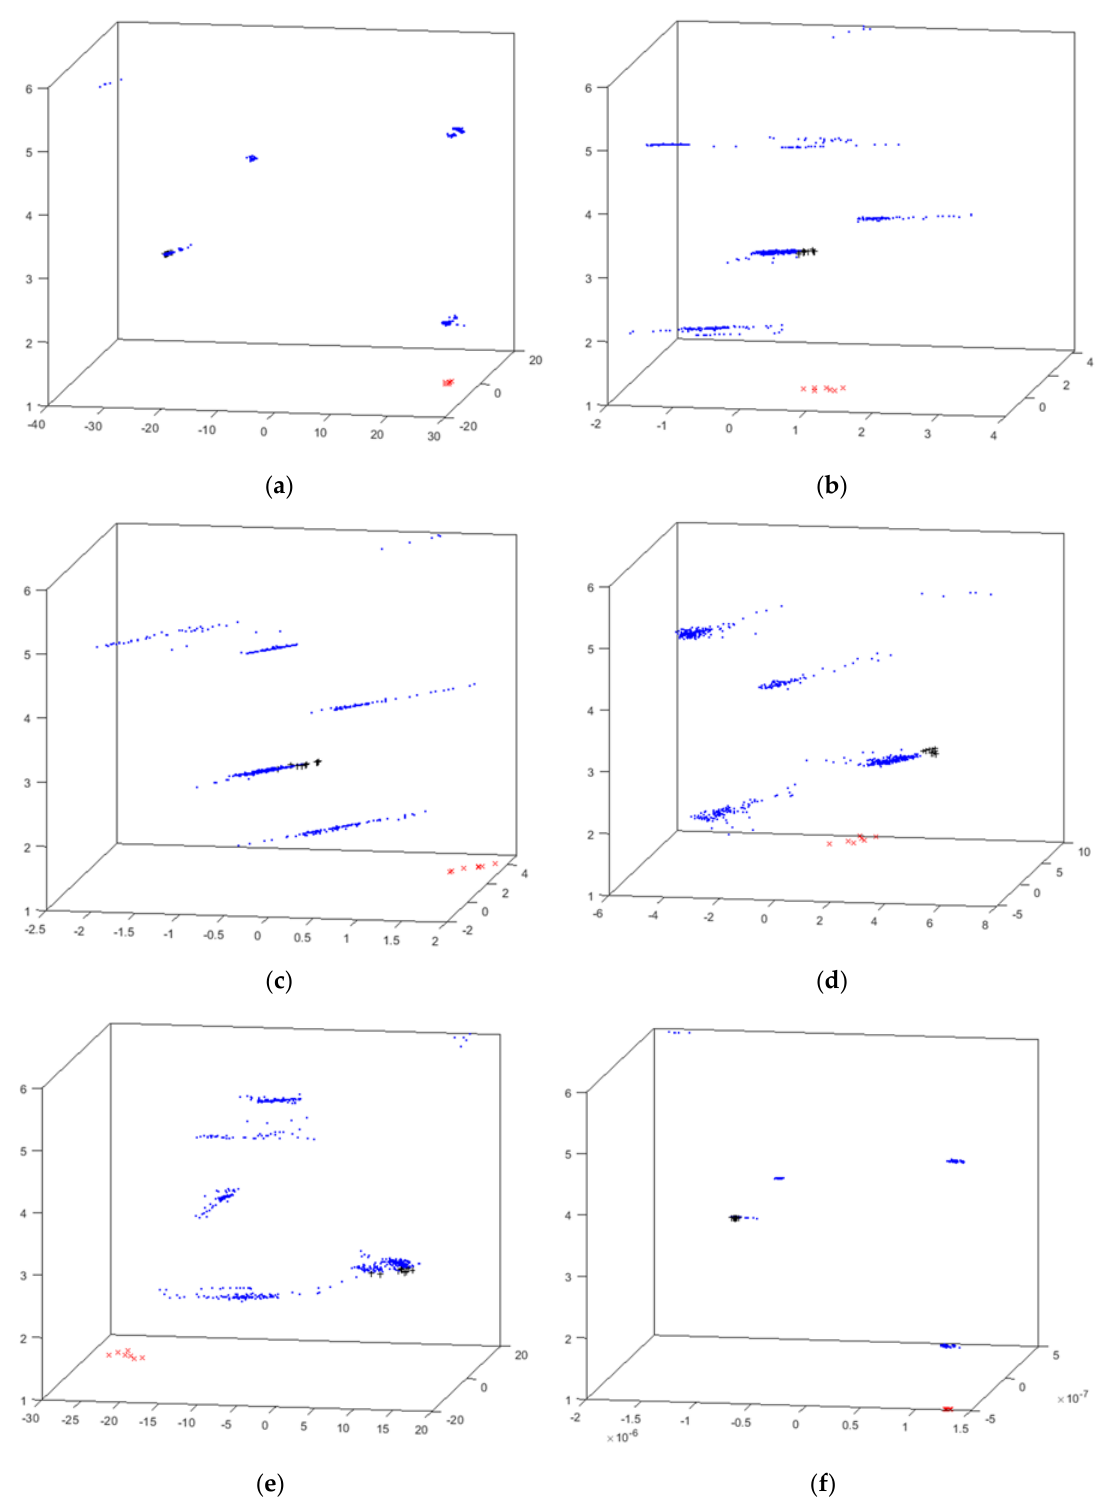
Figure 8. HUEP visualizations of the cyclone dataset. EPP+hierarchical. ( a ) HUEP: PCA+hierarchical clustering ( k = 6, Cityblock, and weighted). ( b ) HUEP: MLHL+hierarchical clustering ( k = 6, Cityblock, and weighted). ( c ) HUEP: CMLHL+hierarchical clustering ( k = 6, Cityblock, and weighted). ( d ) HUEP: CMDS–Seuclidean+hierarchical clustering ( k = 6, Cityblock, and weighted). ( e ) HUEP: SM+hierarchical clustering ( k = 6, Cityblock, and weighted). ( f ) HUEP: FA+hierarchical clustering ( k = 6, Cityblock, and weighted).